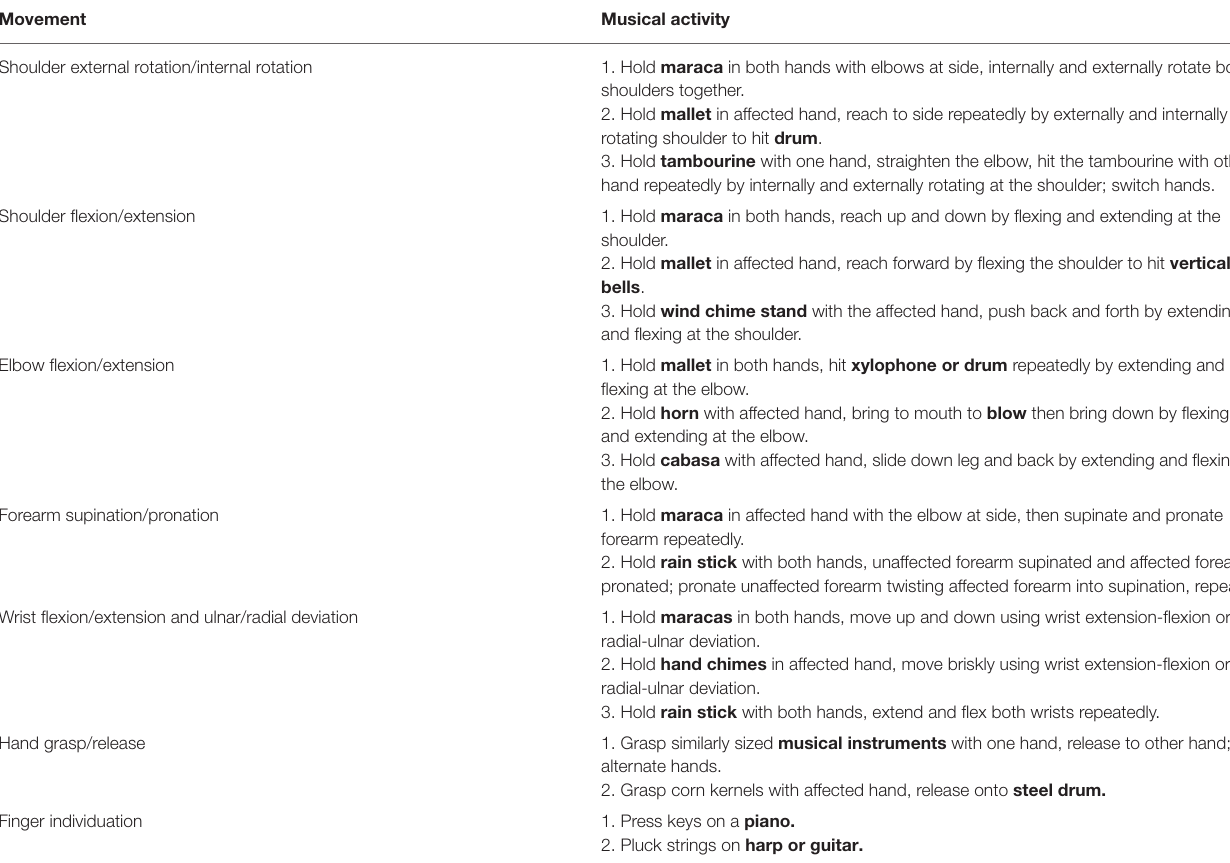
TABLE 2 | Movements performed during MULT-I. Movement Musical